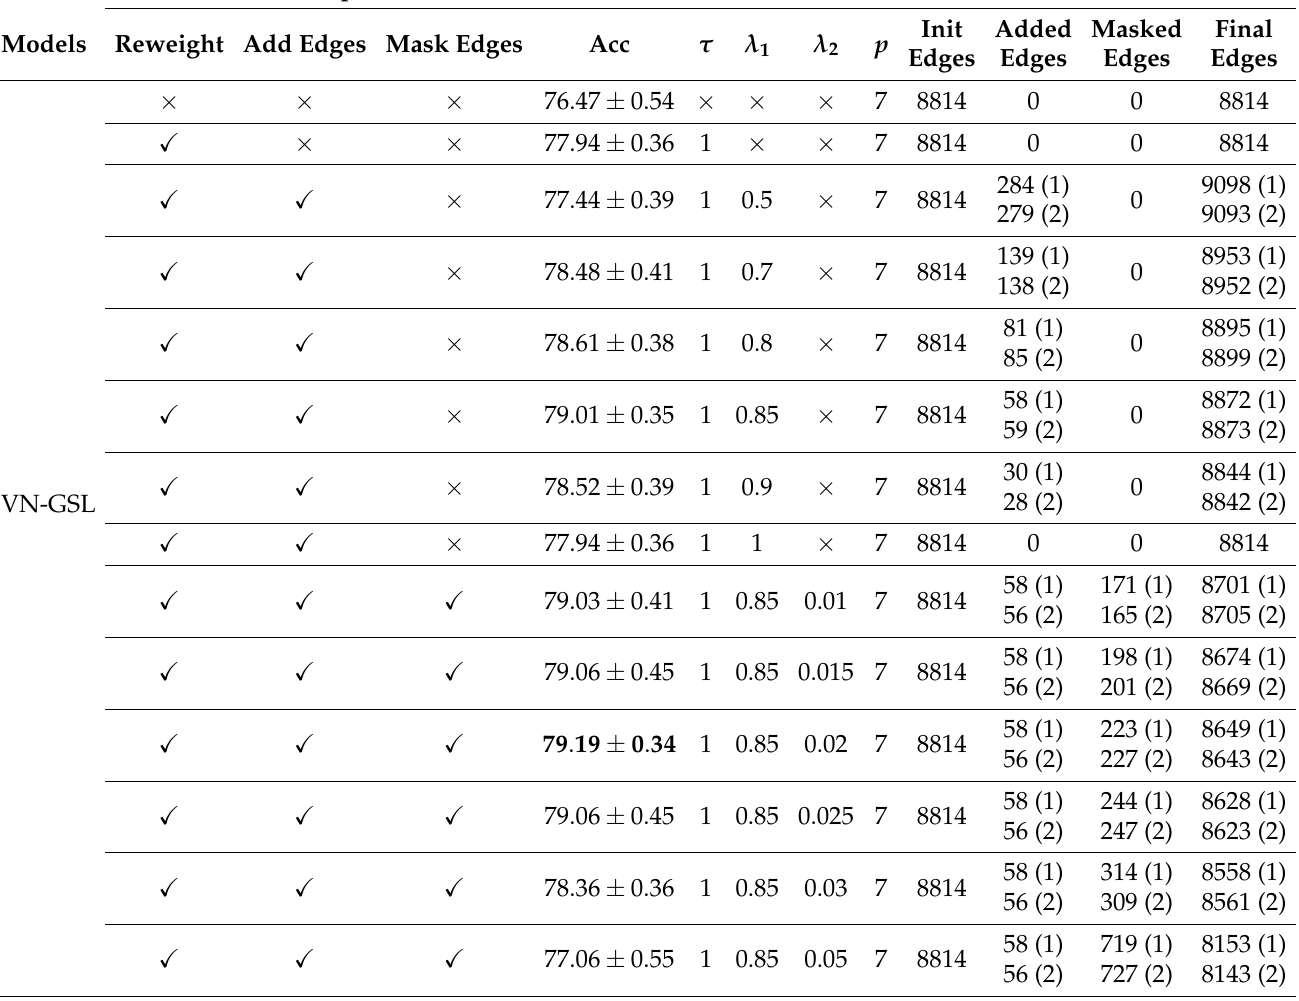
Table A4. Node classification mean accuracy ( % ) ± stdev for different components (we utilize a two-layer VN-GSL model, where the graph learned by the first layer is denoted as (1) and the graph learned by the second layer is denoted as